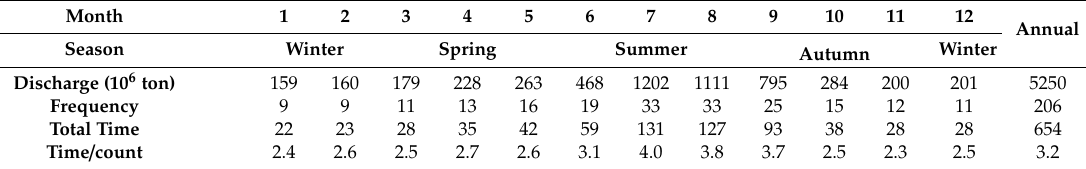
Table A1. Monthly freshwater discharge in Geumgang Estuary (Sep. 1994 – Aug.